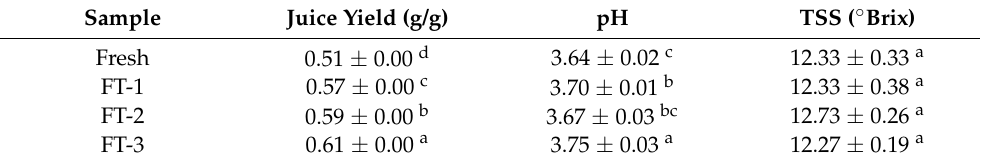
Values presented as mean ± standard deviation ( n = 3). Different letters in each column denote significant differences ( p <